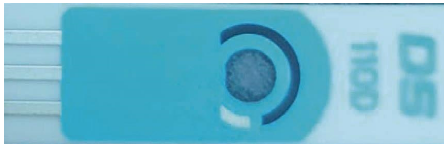
Figure 1: Te photographic picture of the screen-printed mi- crochip assembly. Table 1: Sensitive layer composition of the terbinafne microchip